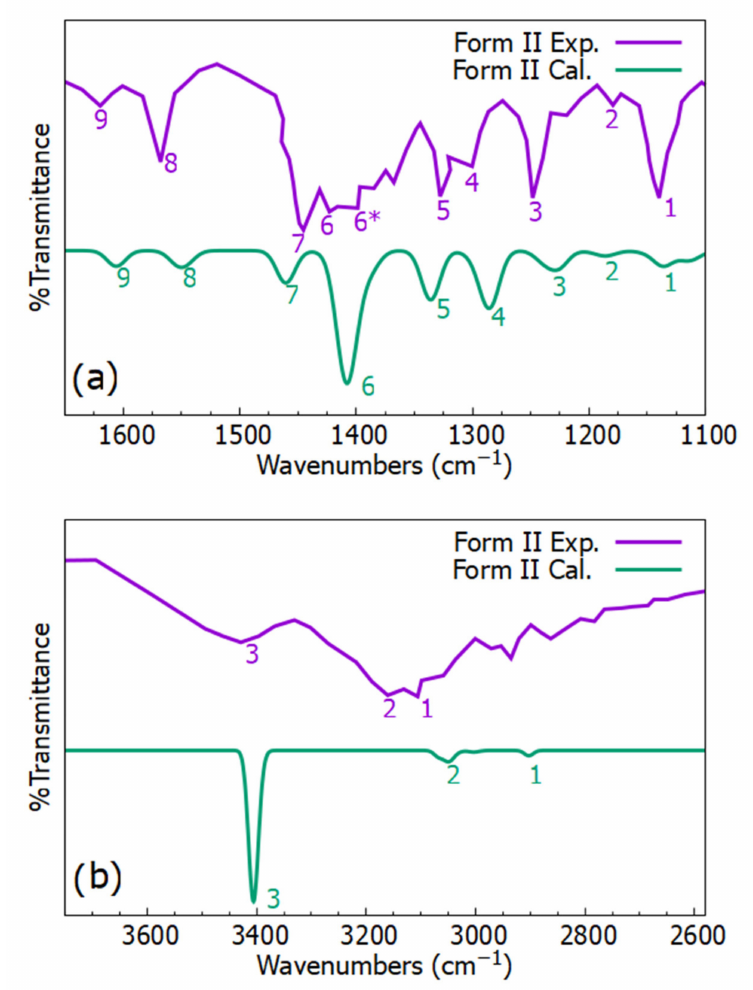
Figure 5. FT-IR spectra of triclabendazole form II at frequencies ( a ) from 1100 cm − 1 to 1600 cm − 1 and ( b ) from 2600 cm − 1 to 3600 cm − 1 . The purple curve represents experimental (Exp.) results [12] which were conducted at atmospheric pressure and room temperature. The green curve represents calculated (Cal.) results, which were obtained at atmospheric pressure and a temperature of 0